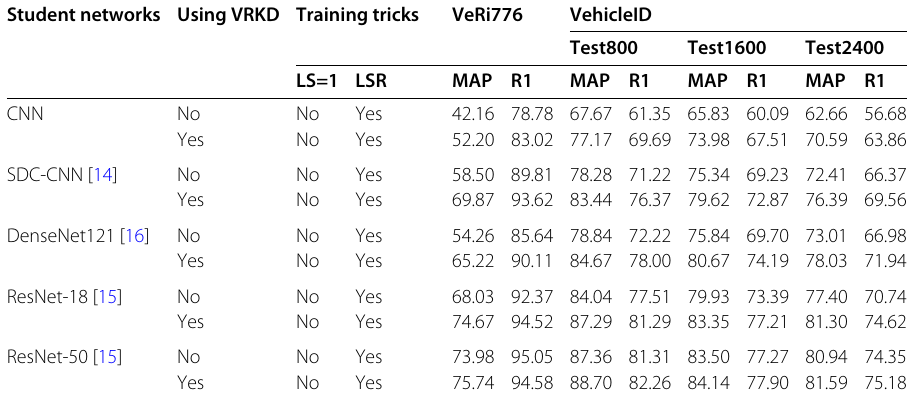
Table 3 The role (%) of viewpoint robust knowledge distillation on the VeRi776 [1] dataset and the VehicleID [2] dataset